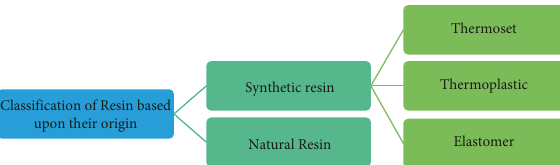
Figure 1: Classification of resins.